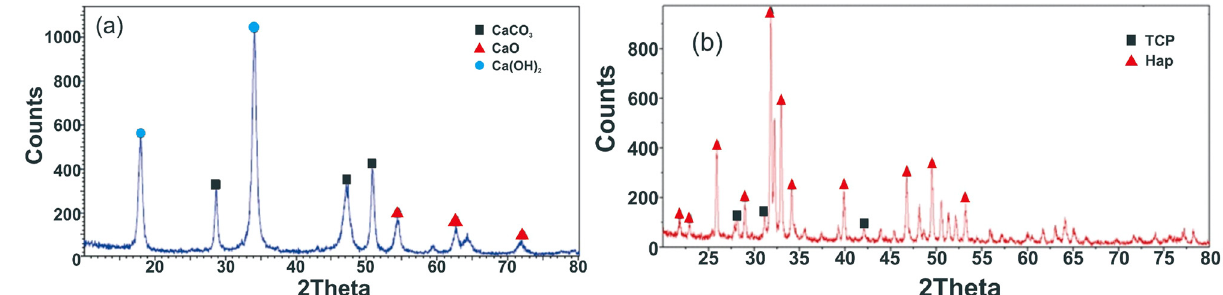
Figure 4: XRD of ( a ) coral milling for 20 h and ( b ) synthesized